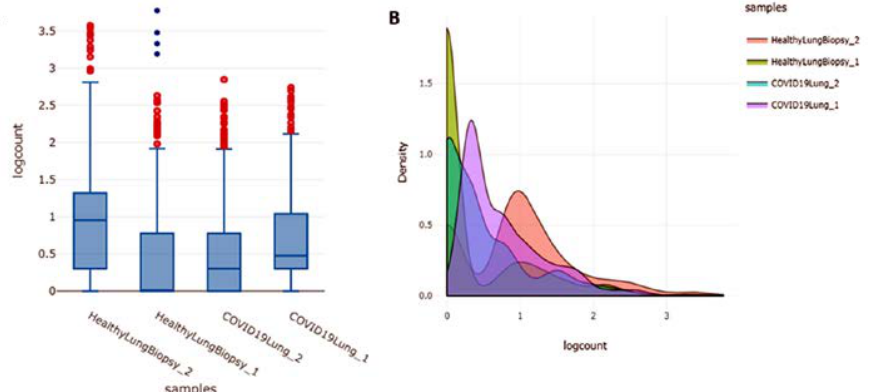
Fig. 1. (A) Boxplot for describing center and variability of the data used in the study; (B) Density plot which uses a kernel density estimate to show the probability density function of the